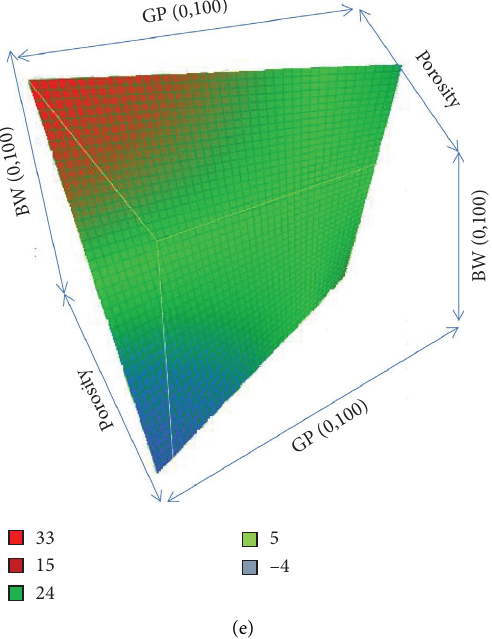
Figure 7: Isoresponse surfaces of the compressive strengths at 7, 14, and 28 days, and water absorption with